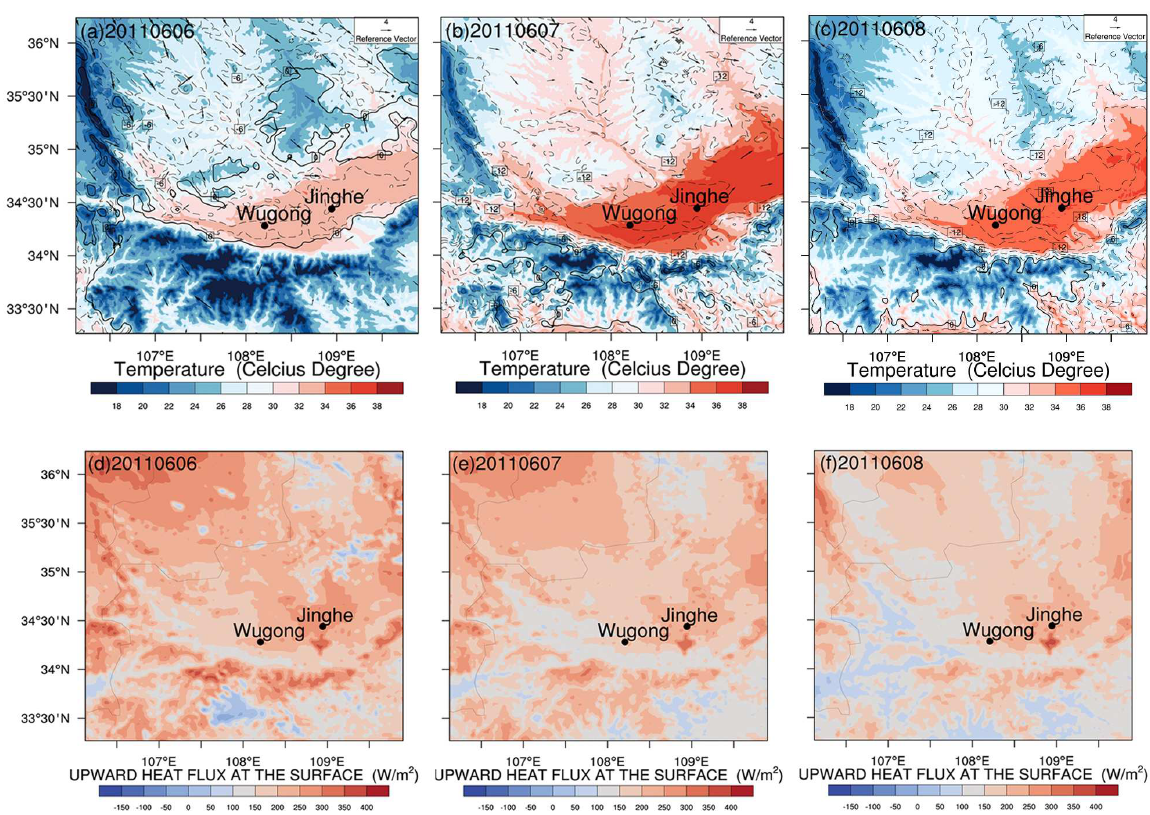
Fig 5. The near-surface meteorological features during 2011 DHW. (a-c) WRF Simulated wind, relative humidity, and temperature field near surface in domain3 at 14:00 (LST) through June 6 to 8, 2011. Coloredcontour indicatestemperaturefield at 2m height. Arrows indicate relative wind speed and direction at 10 m height. The black contour shows the field of differencebetween simulated relative humidity and 30% (i.e. the humidity criteria of dry-hot wind occurrence, solid line), and dashed line shows the negative value only, omitting positive value. (d-f) Color shading indicatesWRF simulatednear-surfacesensibleheat flux at corresponding